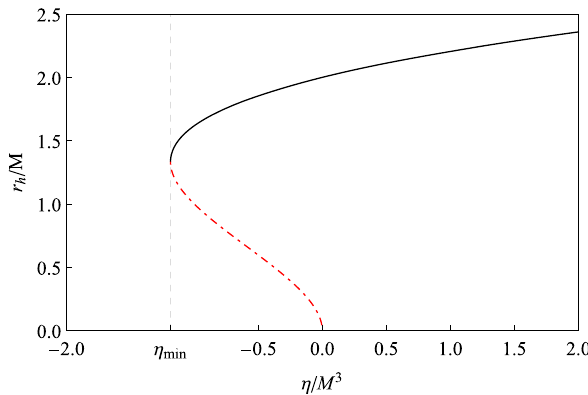
Fig. 1 The solid (black) curve gives the event horizon position as a function of the deformation parameter. The dot-dashed (red) curve rep- resents a second (inner) horizon which appears for negative values of the deformation parameter. We notice that there is a minimum value of the deformation parameter, namely η/ M 3 = η min ≡ − 32 / 27, for the line element (3) to describe a black